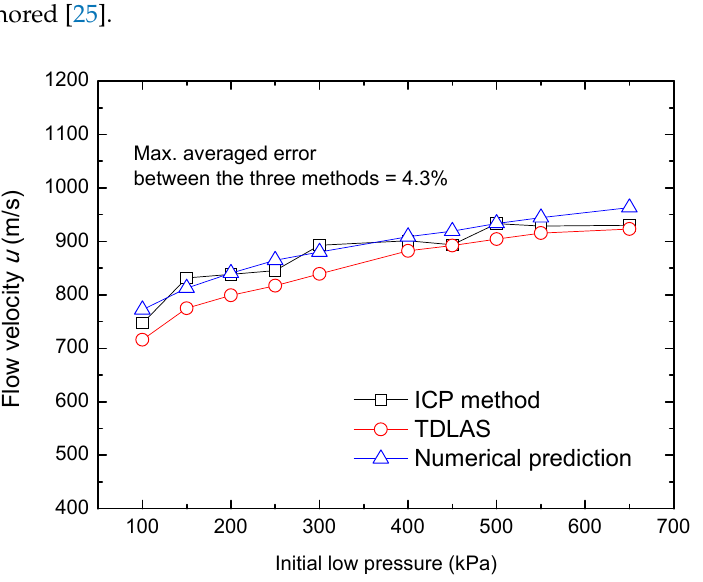
Figure 8. Gas flow velocities in the low-pressure section of the shock tube as determined using three methods.